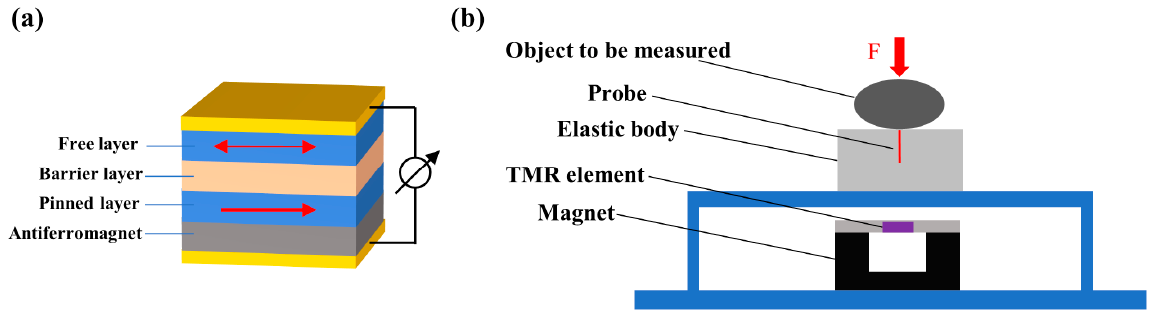
Figure 4. ( a ) Illustration of the structure of TMR sensors; ( b ) Structural diagram of the tactile sensor with a commercial TMR sensor.